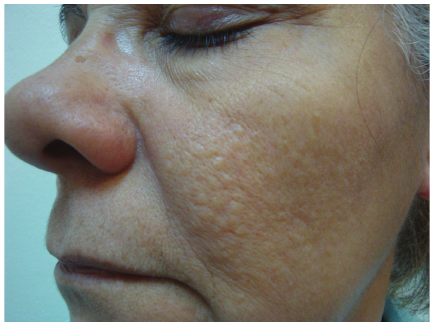
Figure 1: Normochromic grouped papules in the left malar region.